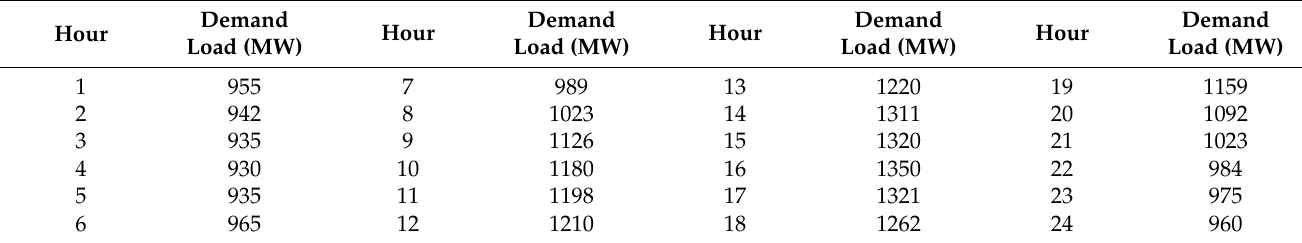
Table 3. 24 h Power on Demand Throughput.